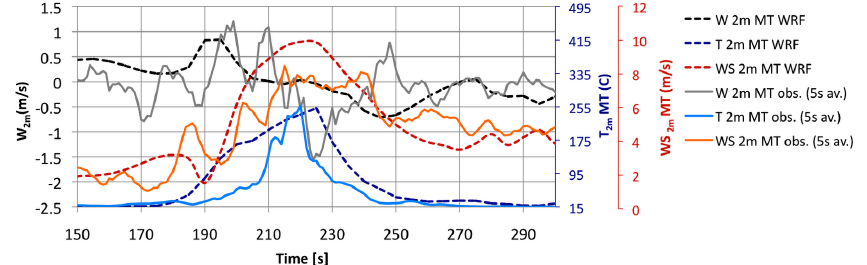
Fig. 12. Time series from the MT of the simulated (dashed lines) and observed (solid lines) updraft velocity ( W ), temperature ( T ) and horizontal wind speed (WS) at 2m. Observational results are presented as 5s averages of the original 1Hz data.